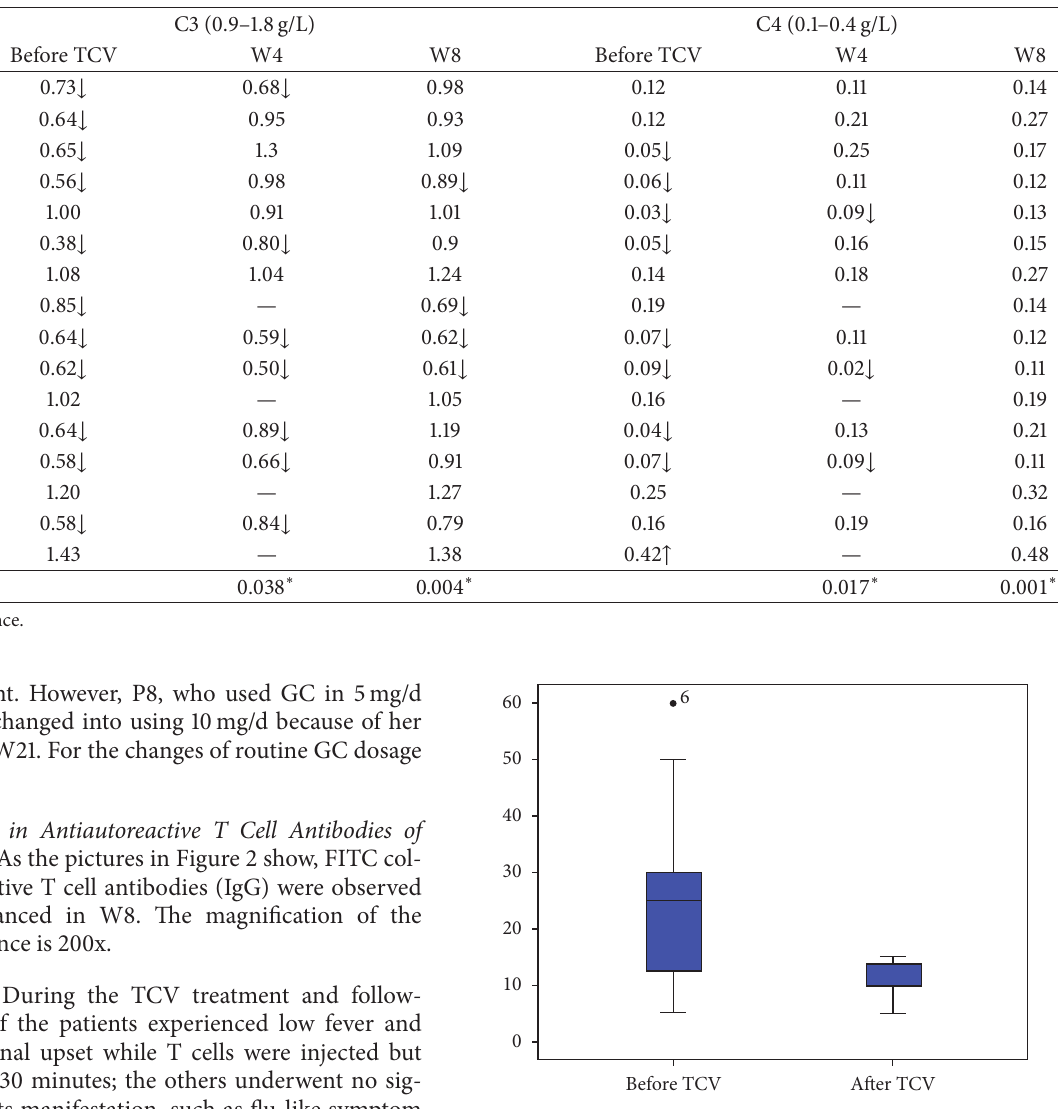
Table 3: The changes in C3 and C4 parameters of patients.